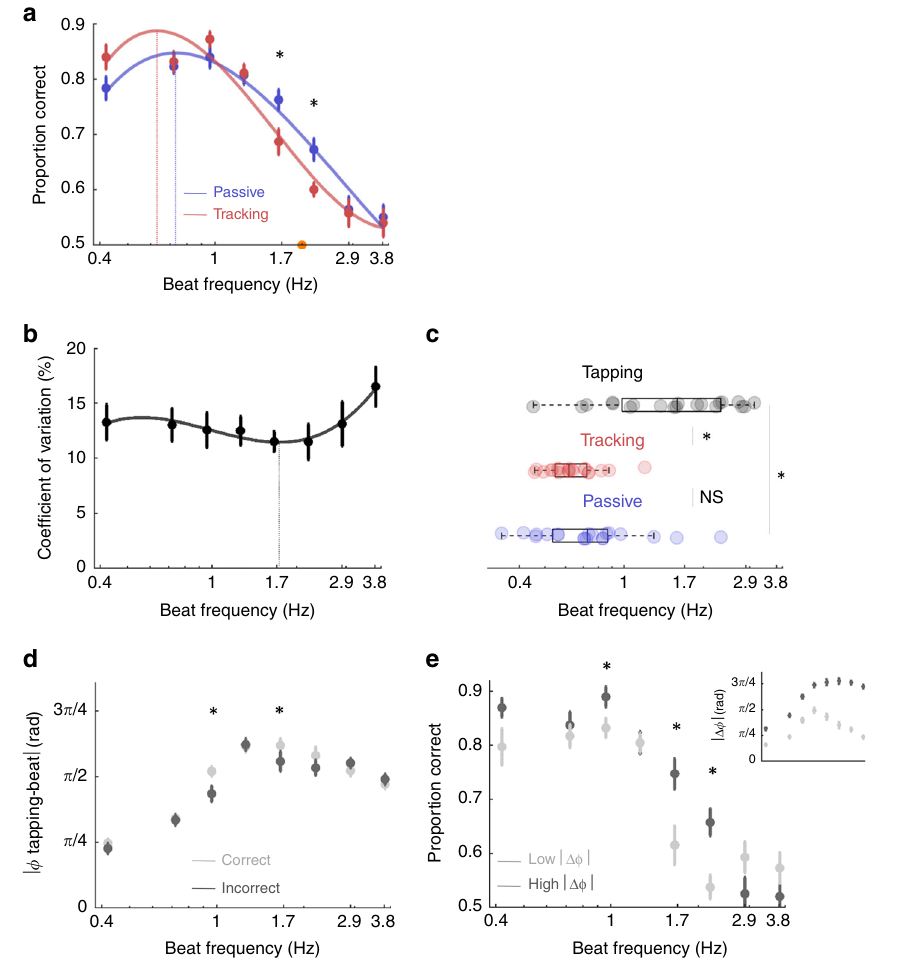
Fig. 4 Motor contribution to visual temporal attention. Experiment 5. a Average performance per condition in the passive (blue) and tracking (red) sessions. b Coef fi cient of variation (CV) of guided tapping across conditions in the tracking session. c Individual estimates of the optimal tempo of visual temporal attention in the passive (blue) and tracking (red) sessions (from a ) and of motor tapping in the tracking session (black; from b ). d Sensorimotor simultaneity ( Φ ; in radian) across conditions in the tracking session, for correct (light grey) and incorrect (dark grey) trials. e Average performance per condition in the tracking session for trials with low (light grey) and high (dark grey) sensorimotor simultaneity indexes. The inset plot indicates the associated sensorimotor simultaneity indexes. Same conventions as in Fig. 2. Error bars indicate s.e.m. ( n = 20; paired t -tests; * p < 0.05; NS non- signi fi cant). Boxplots represent median and 1.5 times the interquartile